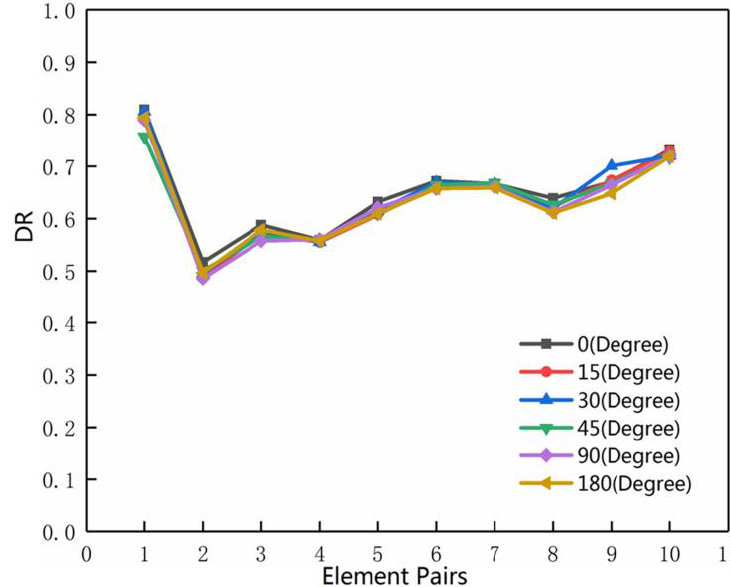
Figure 22. DR of 10 pairs of elements with the same name under different rotation angles using DTRM.